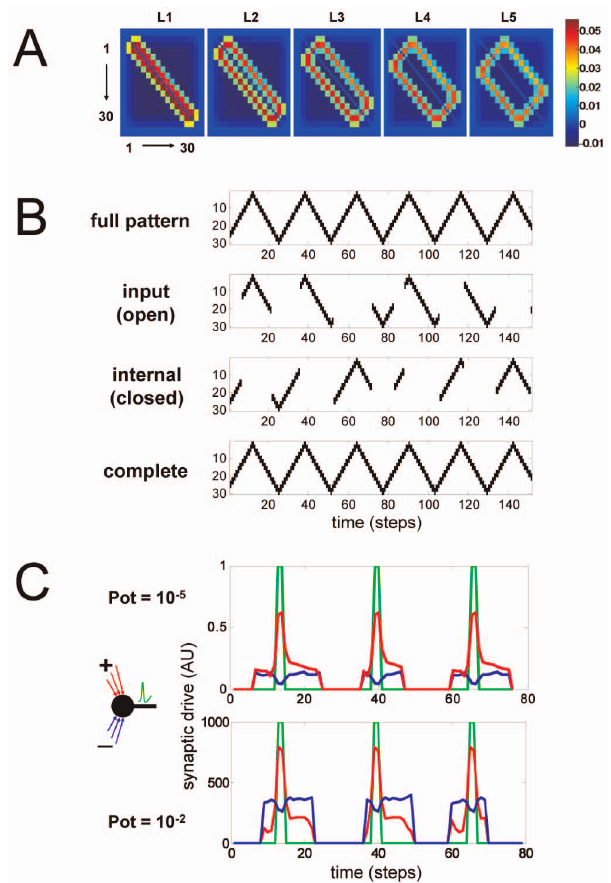
Figure 2. A thirty neuron SSM network trained on input spikes in the form a triangular wave. ( A ) Synaptic weight matrices for different latency conduction delays (1–5 time steps). Positive values (red) correspond to activating connections and negative values (blue) to inhibitory ones. ( B ) full pattern of activity in the sensory environment (full pattern), input activity during the open state (open), internal activity during the closed state (closed), and the combined (complete). Pattern completion during the closed state is a perfect match to the missing input. SSM parameter choices were as follows: potentiation strength ( a ): 4 6 10 2 5 , spike-rate memory (m s ): 100, potentiation memory (m p ): 100, state switching period: (Gaussian, t m =15, t s =5), neuron firing threshold (V t ): 0.5, sigmoid sharpness (S): 10, latency range (L): 5. Spike-rate memory (m s ) and potentiation memory (m p ) are the widths of averaging time window for calculating mean spike-rate and mean potentiation, respectively. ( C ) Input synaptic drive into a single neuron for activating input (red), and inhibitory input (blue). Spikes are represented in green. The comparisons were performed after stabiliza- tion of learning. The two simulations are identical except for a thousand-fold higher potentiation scale ( a ). Each neuron has 290 synaptic inputs (29 neurons 6 5 latencies 6 2